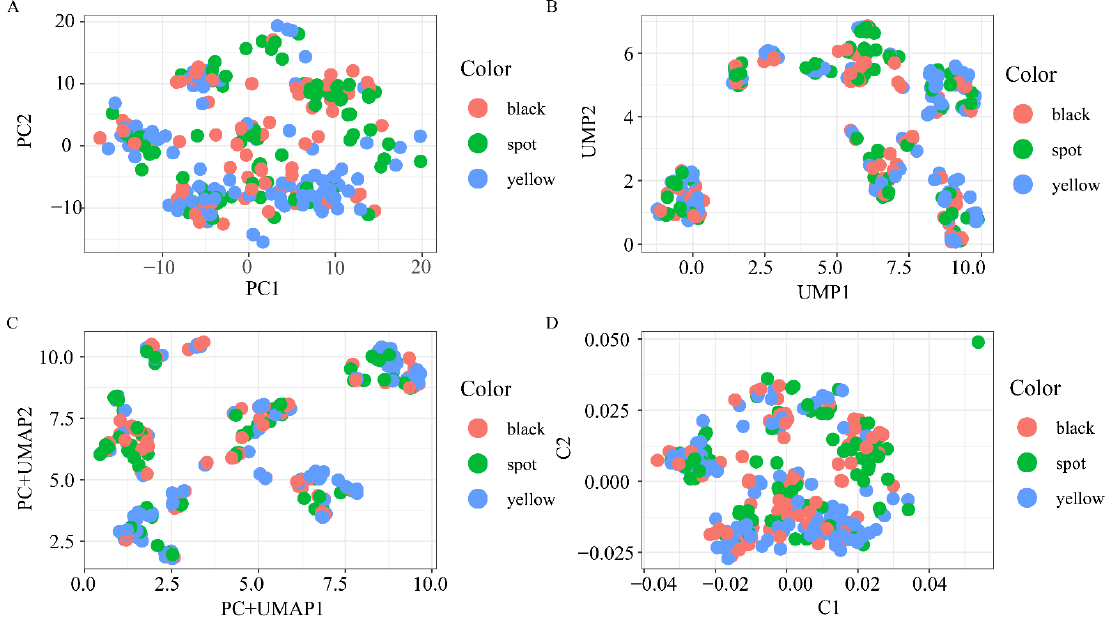
Figure 2. Two-dimensional illustrations of biobank-scale genotype data from the F 2 population by the four dimensionality reduction methods: ( a ) PCA; ( b ) UMAP; ( c ) PC+UMAP; and ( d ) MDS. The color of individual dots indicates different shin colors.